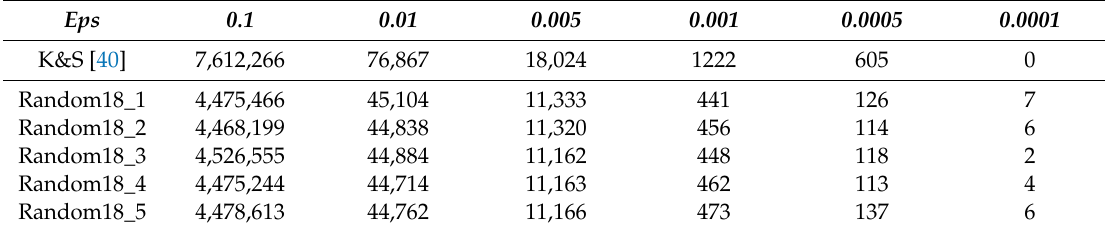
Table 22. Number of opposite pairs for selected angular accuracy values eps in Kuminski and Shamir catalog [40] and in several random catalogs with the same number of objects and the same angular distribution on the celestial